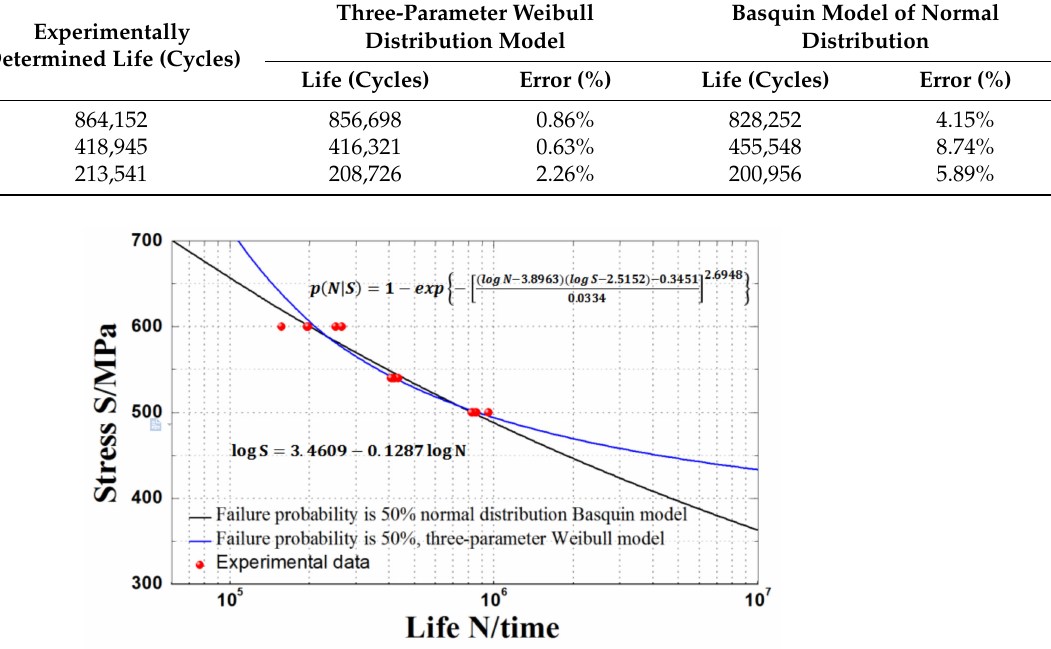
Table 7. Comparison of fatigue life of HL-type ultra-high strength sucker rod based on the three- parameter Weibull distribution model and the normal distribution Basquin model.